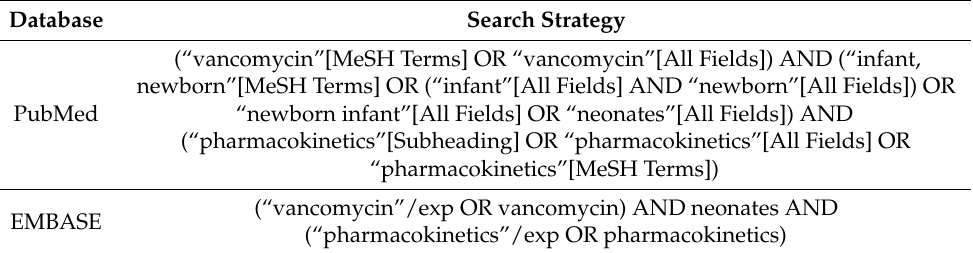
Table 4. Detailed search